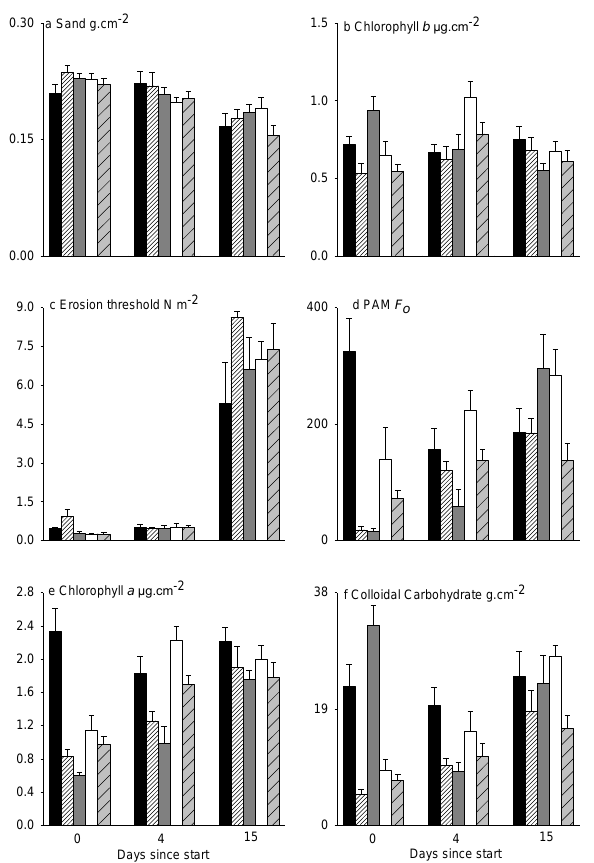
Fig. 1. Means (+ S.E., n = 3 plots) of selected variables in treat- ments that were physically disturbed: black, undisturbed; fine stripe, frozen; grey, oven; white, PC2; coarse striped, PC1 (details in